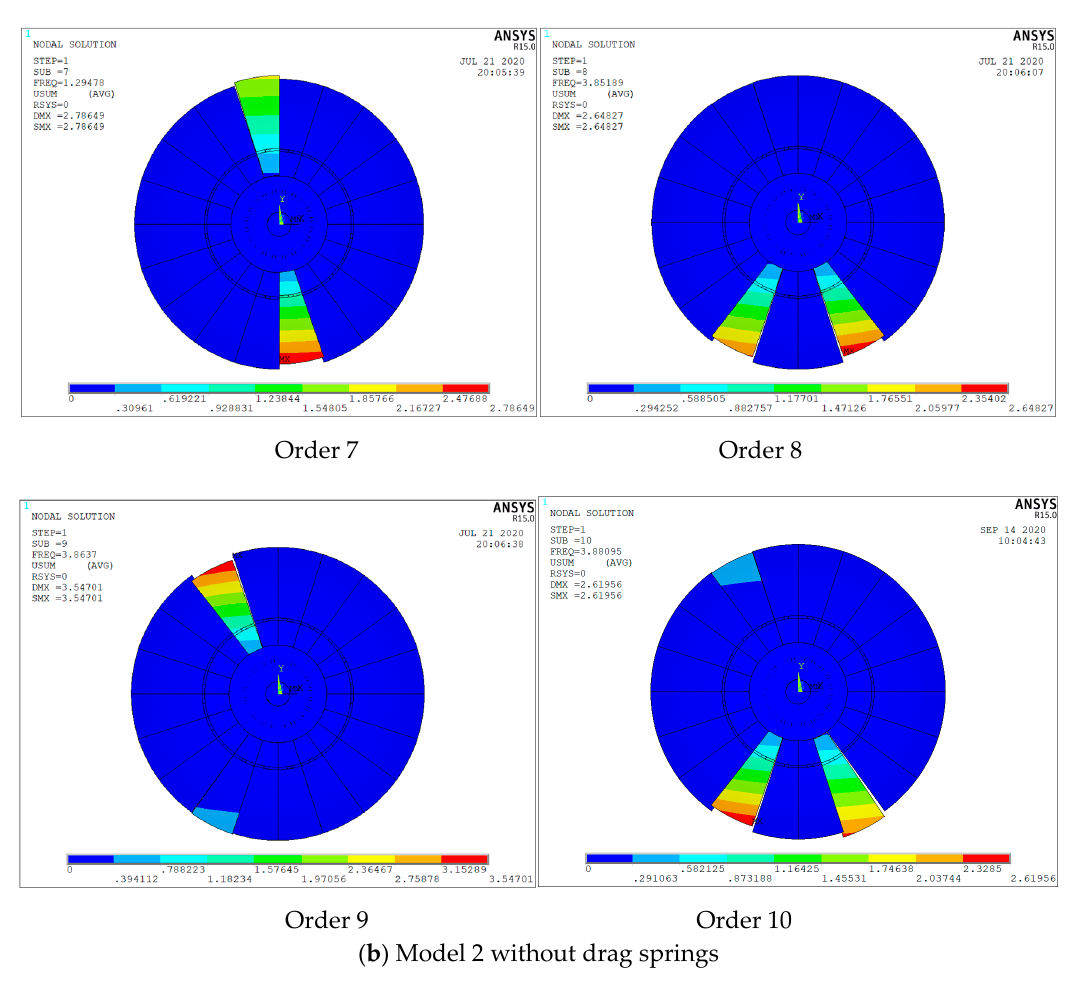
Figure 7. First ten mode shapes of the reflector.